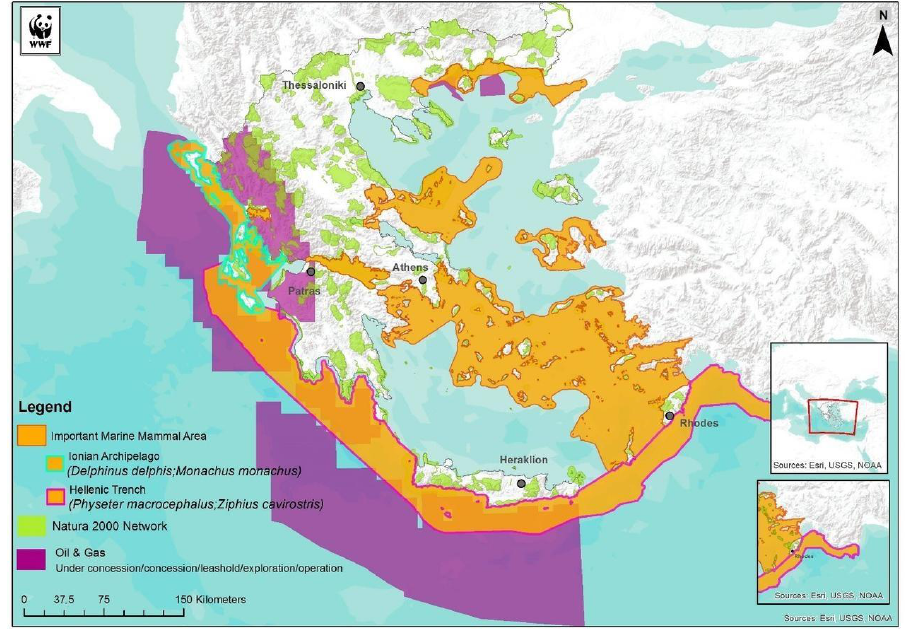
Figure 1. The Hellenic Trench (min. lat. 34 ◦ 8 (cid:48) N, min. long. 20 ◦ 15 (cid:48) E, max. lat. 37 ◦ 15 (cid:48) N, max. long. 28 ◦ 0 (cid:48) E) (https://www.marineregions.org/gazetteer.php?p=details&id=3347 (accessed on 8 May 2022)). Important marine mammal area. Reprinted with permission from Ref. [5]; Copyright 2019 WWF